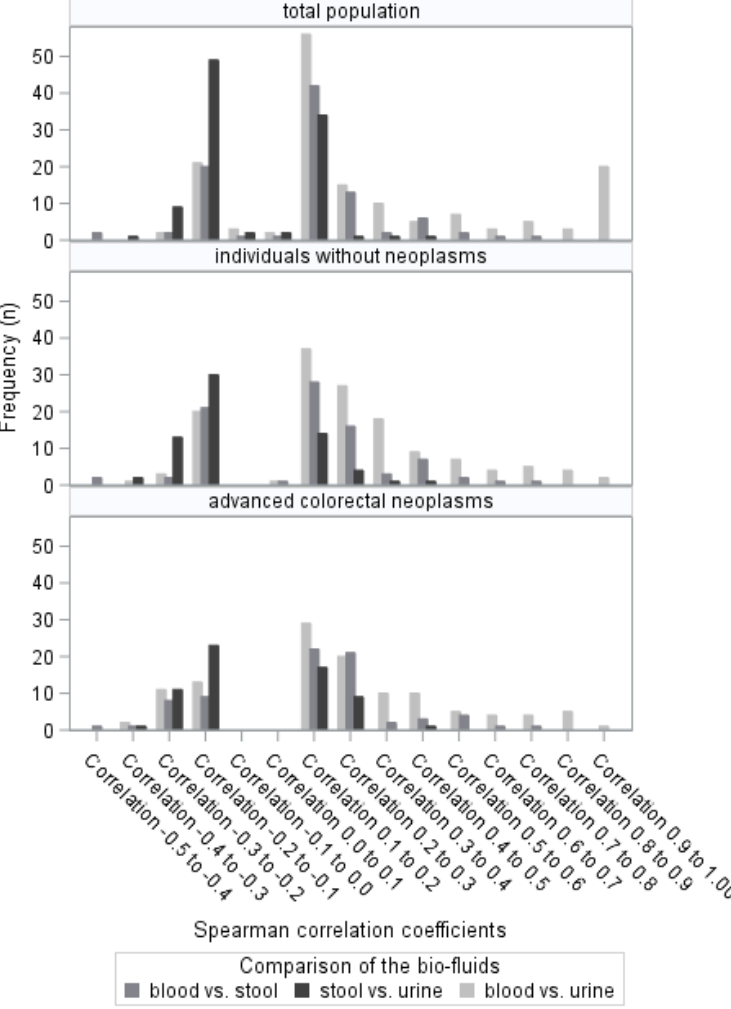
Figure 3. Distribution of the Spearman correlation coefficients (only significant correlations are displayed).